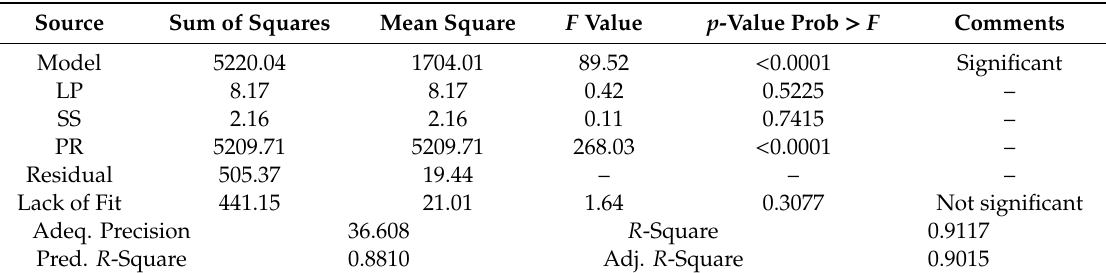
Table 4. Analysis of variance on micro-hardness.